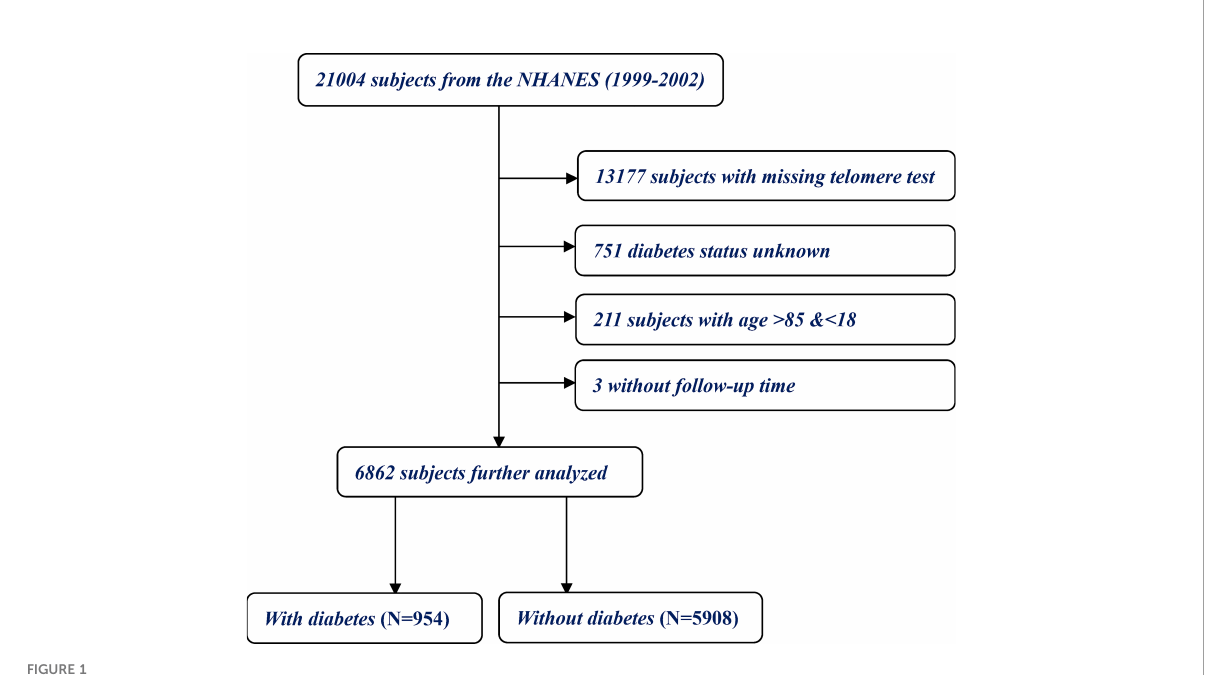
FIGURE 1 The detailed fl ow-chart of study population